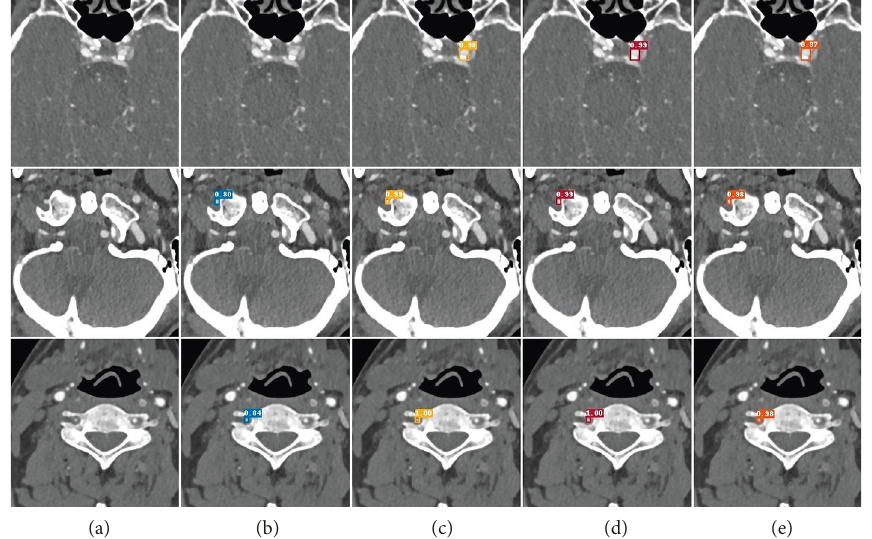
Figure 7: (a–e) Comparison between one-stage and two-stage algorithm prediction. (a) Raw image, (b) Yolov3, (c) Faster R-CNN, (d) Libra R-CNN, and (e) Cascade